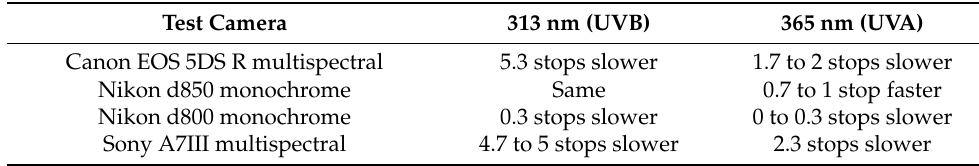
Table 1. Relative sensitivity of test cameras at 313 and 365 nm compared to the monochrome converted Canon EOS 5DS R.